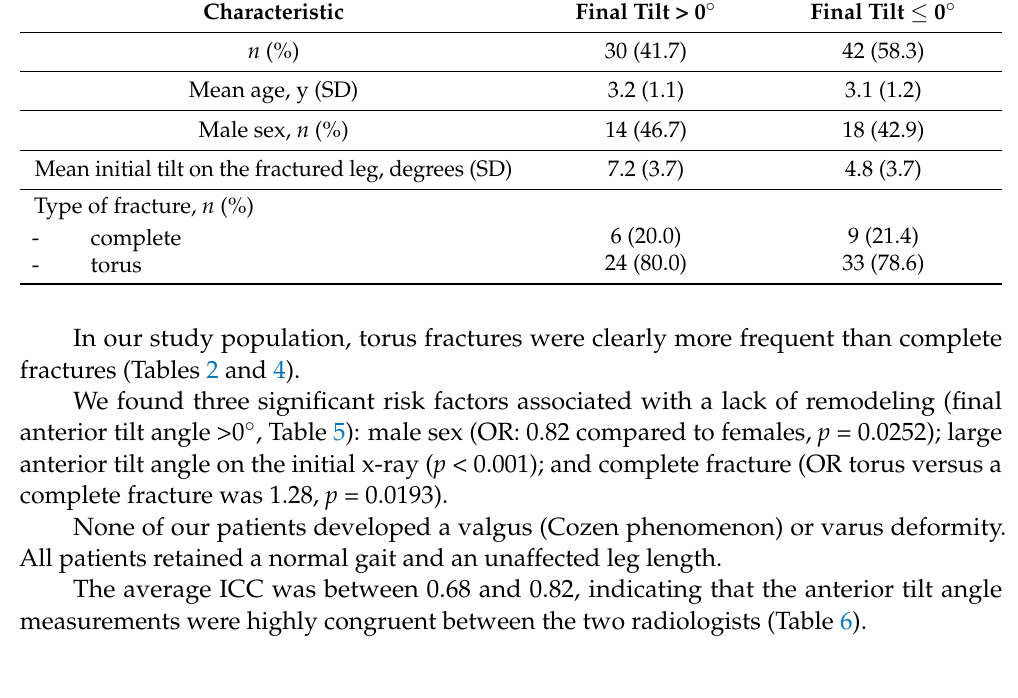
Table 4. Characteristics of children with trampoline fractures of the tibia also had radiographs of the healthy leg ( n = 72/89), categorized by the tilt angle measured at the final exam. Characteristic Final Tilt > 0 ◦ Final Tilt ≤ 0 ◦ n